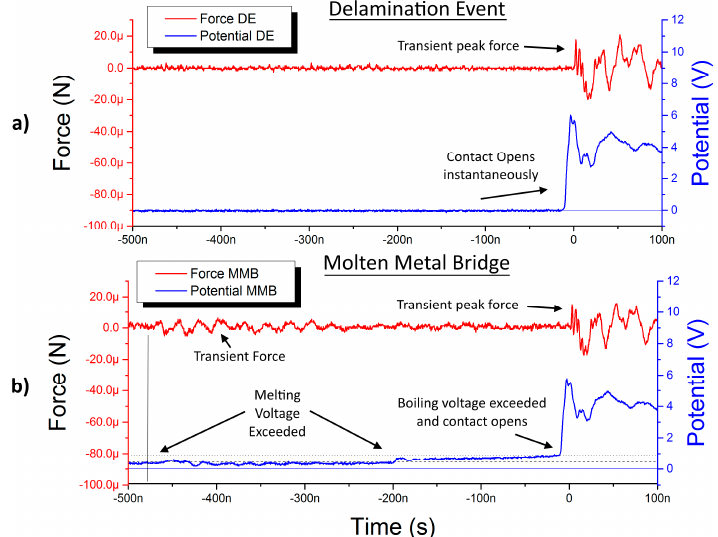
Figure 5. Examples of the force and contact voltage during a Delamination Event ( a ) and Molten Metal Bridge ( b ) from 500 ns before the contact opens with the Transient Peak Force as the contact opens indicated.